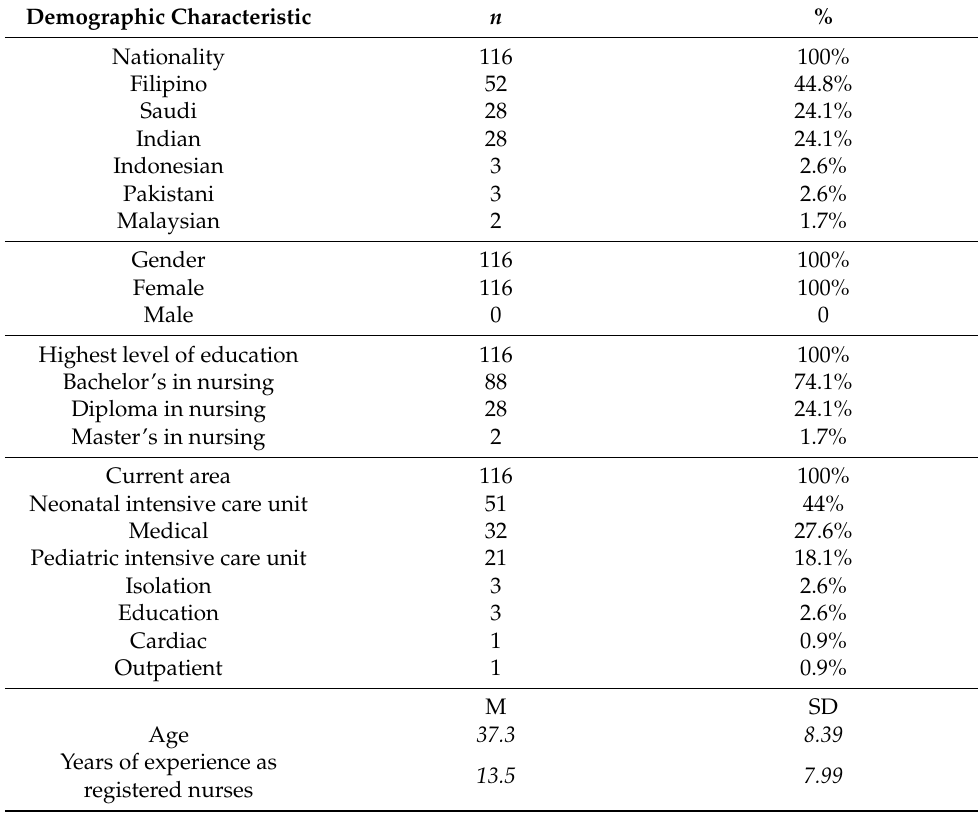
Table 1. Characteristics of participants’ demographics ( N =